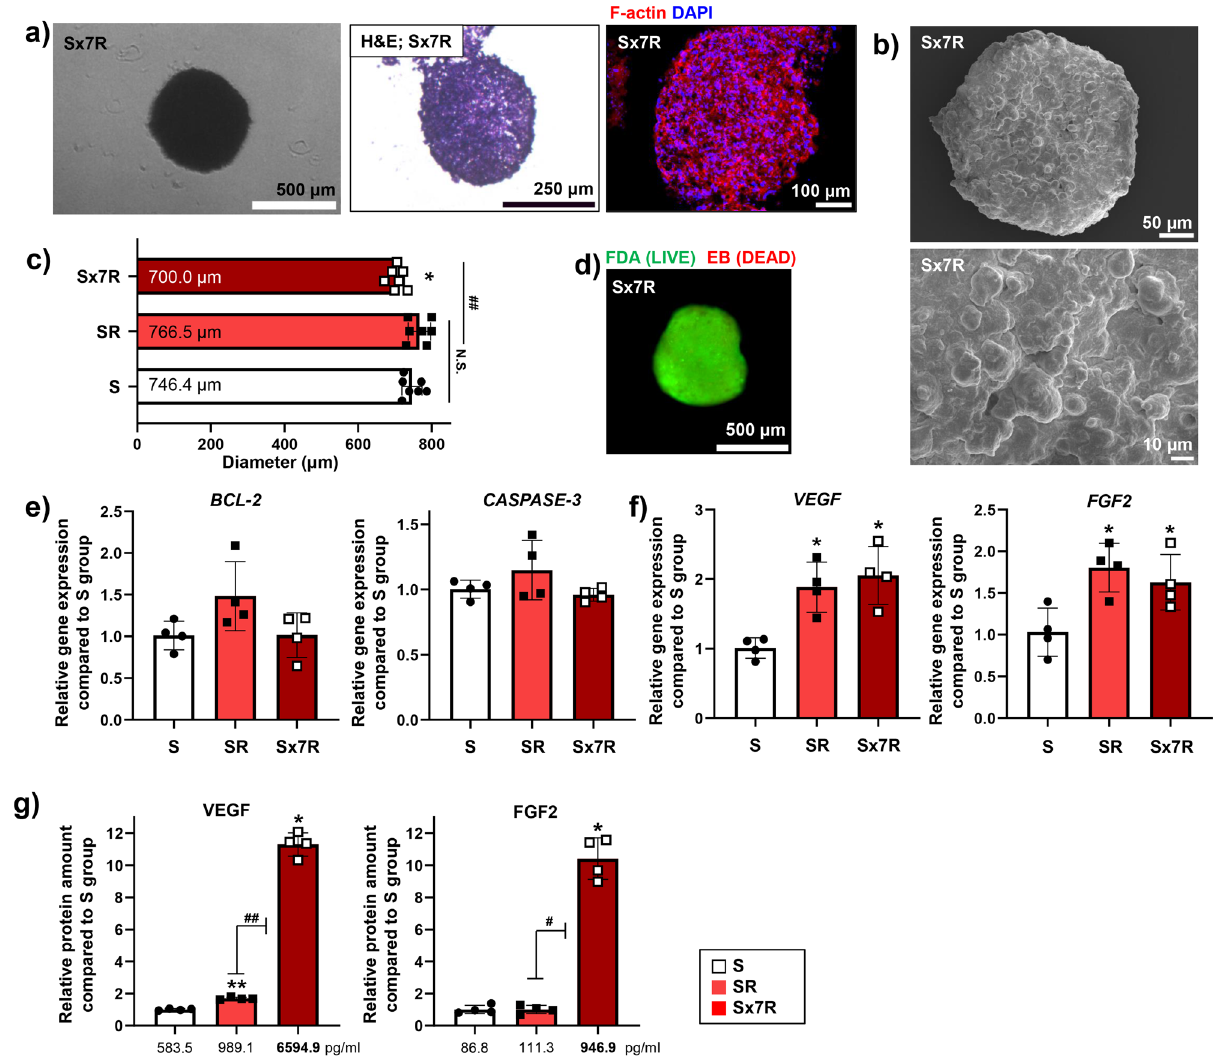
Fig. 4 Structural properties, cell viability, and expression of angiogenesis-related paracrine factors in Sx7R. a Representative morphological features evaluated through H&E and F-actin staining of densely cultured hADSC spheroids treated with red light irradiation. b Representative SEM images showing the surface morphology of the spheroid. c Spheroid diameter measurements ( n = 7, * p < 0.05 vs. S group, ## p < 0.001 vs. each group). The cell viability was evaluated using FDA-EB assay ( d , scale bars = 500 μ m) and the relative expression of BCL-2 and CASPASE-3 in hADSCs was analyzed using the S group as a control ( e , n = 4). f Relative expression of VEGF and FGF2 in the densely - incubated hADSCs spheroid following red light treatment using the S group as a control ( n = 4, * p < 0.05 vs. the S group). g Relative concentration of VEGF and FGF2 in CM evaluated using ELISA ( n = 5, * p < 0.05 vs. S